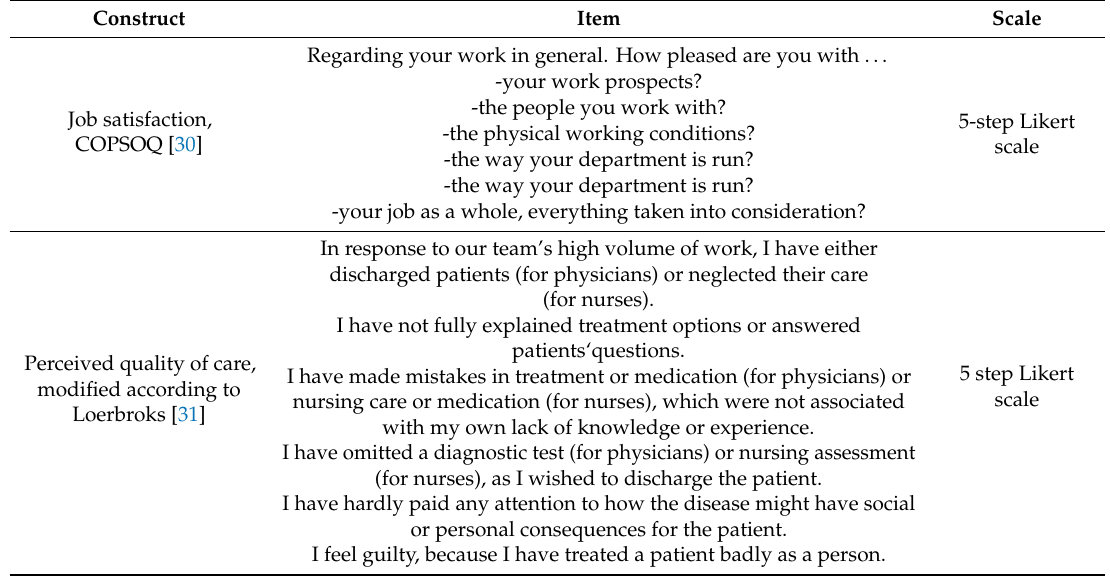
Table 3. Comparison of the constructs job satisfaction and perceived quality of